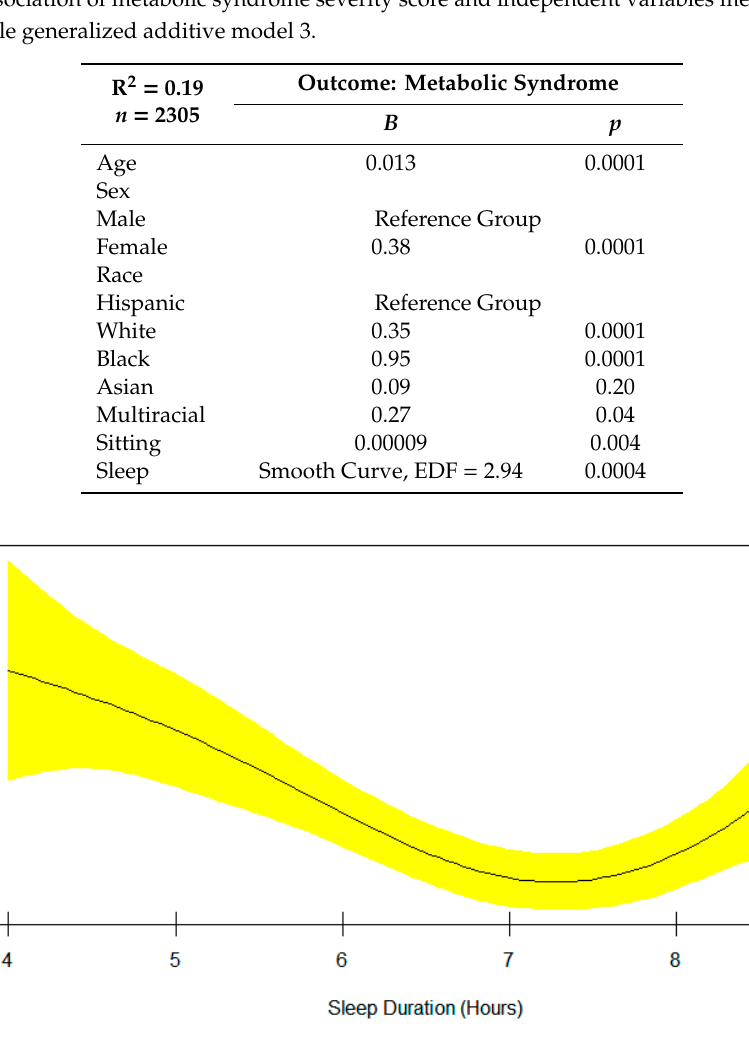
Figure 3. Plots of estimated smoothing spline function of sleep duration with 95% confidence band for the multivariable generalized additive model 4 when the response variable was metabolic syndrome severity score (EDF = 2.94, p = 0.0004).